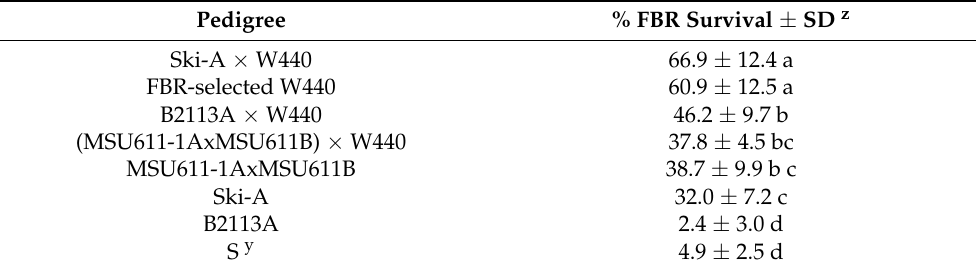
Table 2. Mean percentage (%) survival ± standard deviation (SD) for testcross progenies, male-sterile lines, and inbred W440 selected for resistance to Fusarium basal rot (FBR) in a randomized complete block design with four